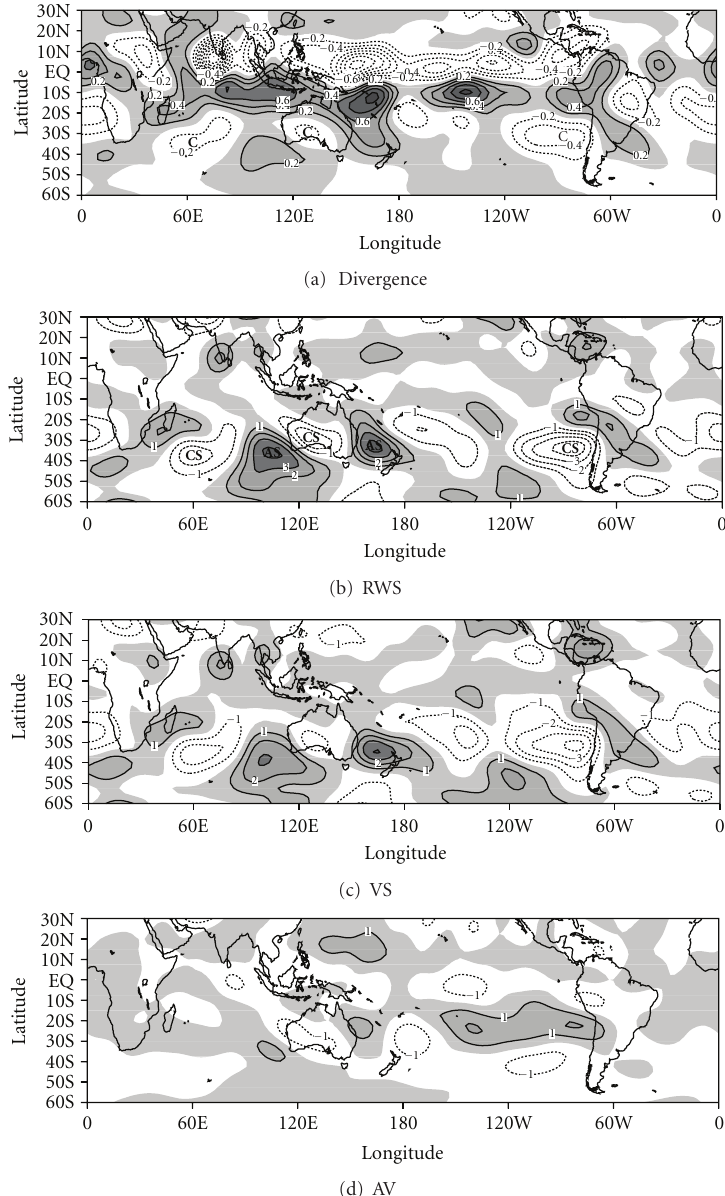
Figure 3: Anomaly for weak HC cases at 200 hPa in JJA for: (a) divergence, (b) Rossby wave source (RWS), (c) vortex stretching term (VS), (d) advection of absolute vorticity by divergent flow term (AV). The shaded areas represent positive values. The divergence contour plot has a contour interval of 0.2 × 10 − 6 s − 1 . RWS and its terms contour plots have contour interval of 1 × 10 − 11 s − 2 . The symbols C and CS are described in the